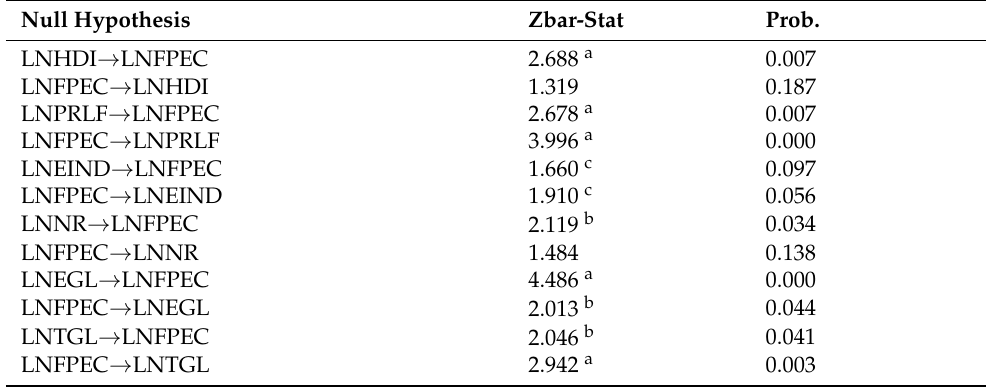
Table 7. The DH Granger causality